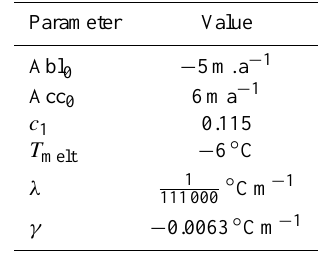
Fig. 1. Ice sheet geometry: an ice cap of thickness H(x,t) lies on a bedrock (in blue) whose topography is B soc (x) . S(x,t) represents the surface altitude of the ice sheet.